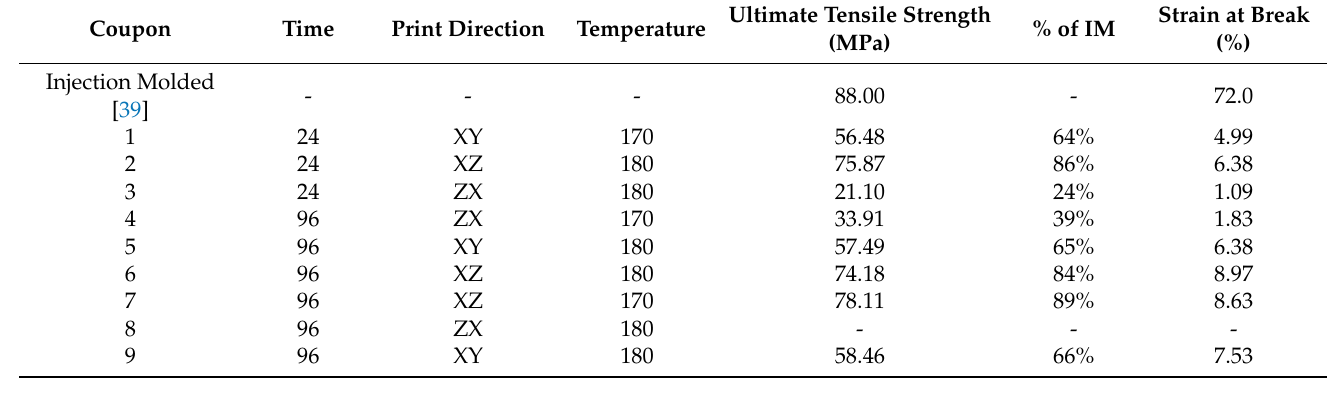
Table 8. Mechanical properties for annealed specimens.